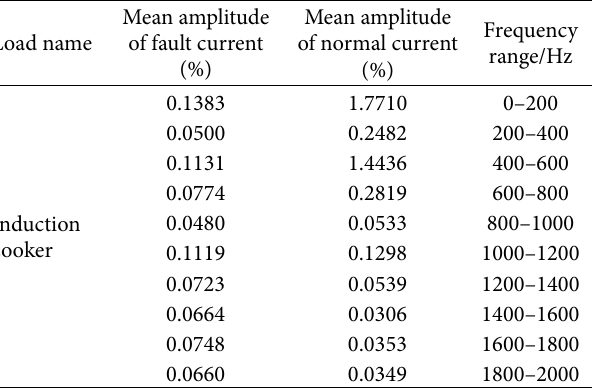
Table 4: Frequency domain feature values of induction cooker load